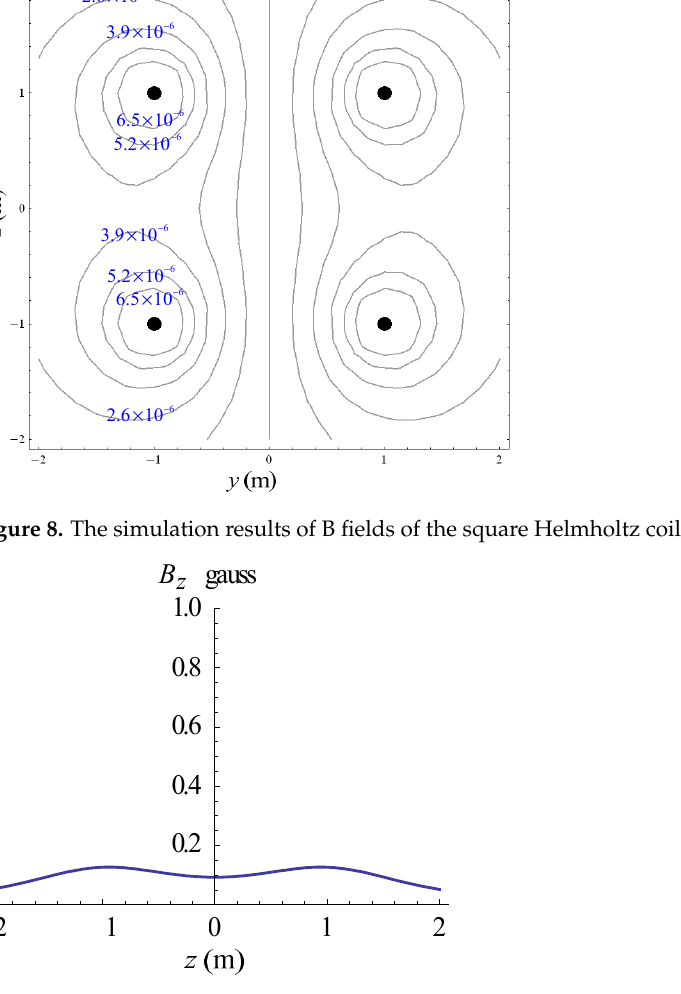
Figure 9. The simulation of B fields of the square Helmholtz coil as the function of the distance along the z-axis.